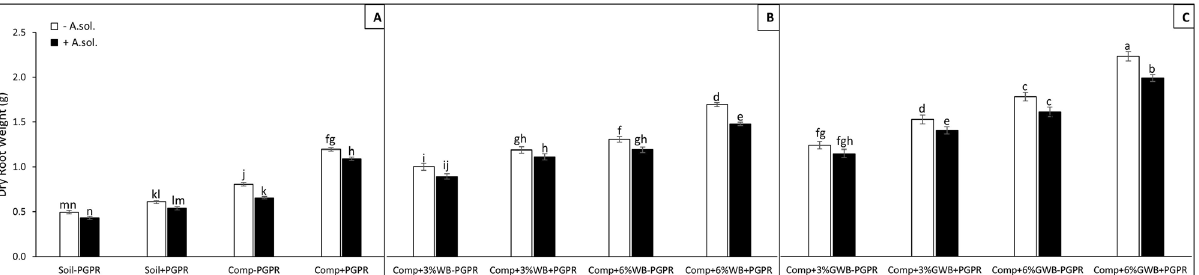
Figure 2. Effect of Alternaria solani and PGPR on dry root weight of tomato raised in various soil substrate compositions including; ( A ) soil and compost (Comp) alone with (+ PGPR) and without PGPR (− PGPR), inoculated (+ A. solani ) or un-inoculated (− A. solani ), ( B ) compost (Comp) with 3 and 6% wood biochar (WB) with (+ PGPR) and without PGPR (− PGPR), inoculated (+ A. solani ) or un-inoculated (− A. solani ), ( C ) compost (Comp) with 3 and 6% Green waste biochar (GWB) with (+ PGPR) and without PGPR (− PGPR), inoculated (+ A. solani ) or un-inoculated (− A. solani ). All values represent mean ± SE, recorded 40 days after transplantation. Bars with different letters on the top suggest significant difference as per Tukey’s HSD test ( P ≤